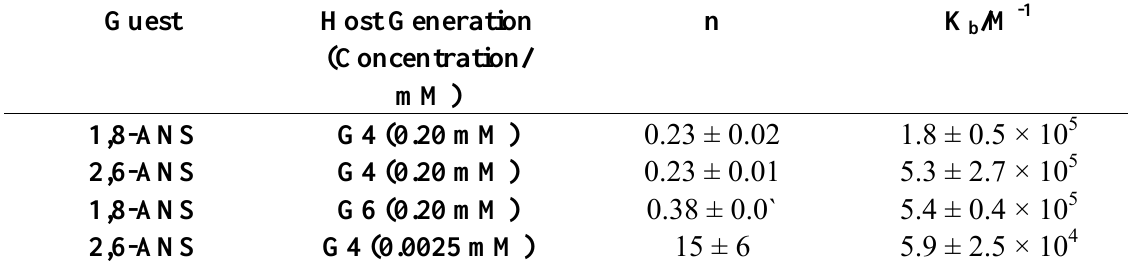
Table 3. Results for the fits of the double fluorometric titration experiments to Equation